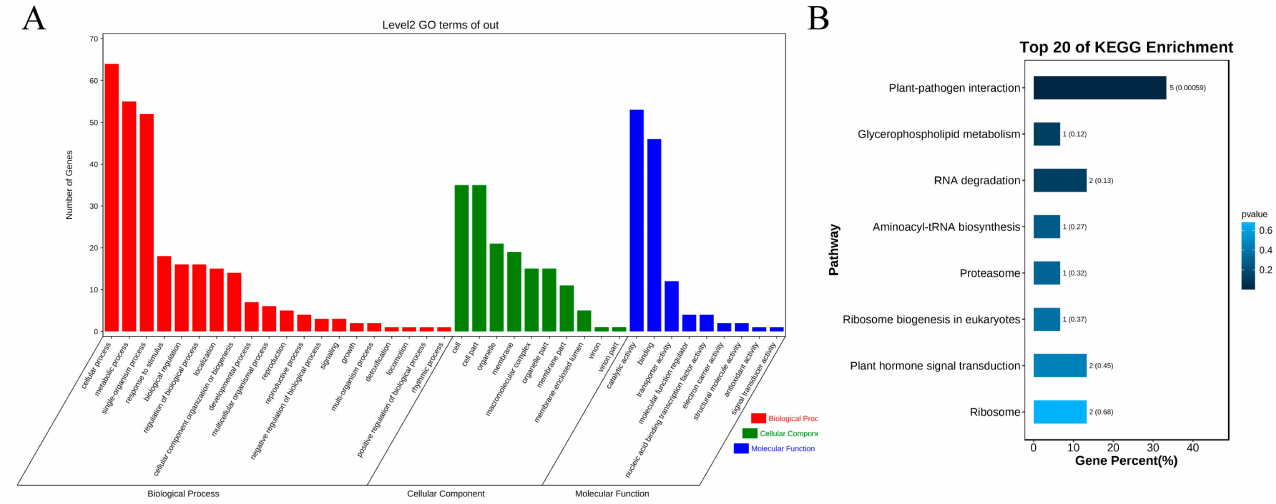
Figure 3. Enrichment analysis of 122 genes in candidate region for LTG tolerance. ( A ), GO classifica- tion. ( B ), KEGG pathway enrichment